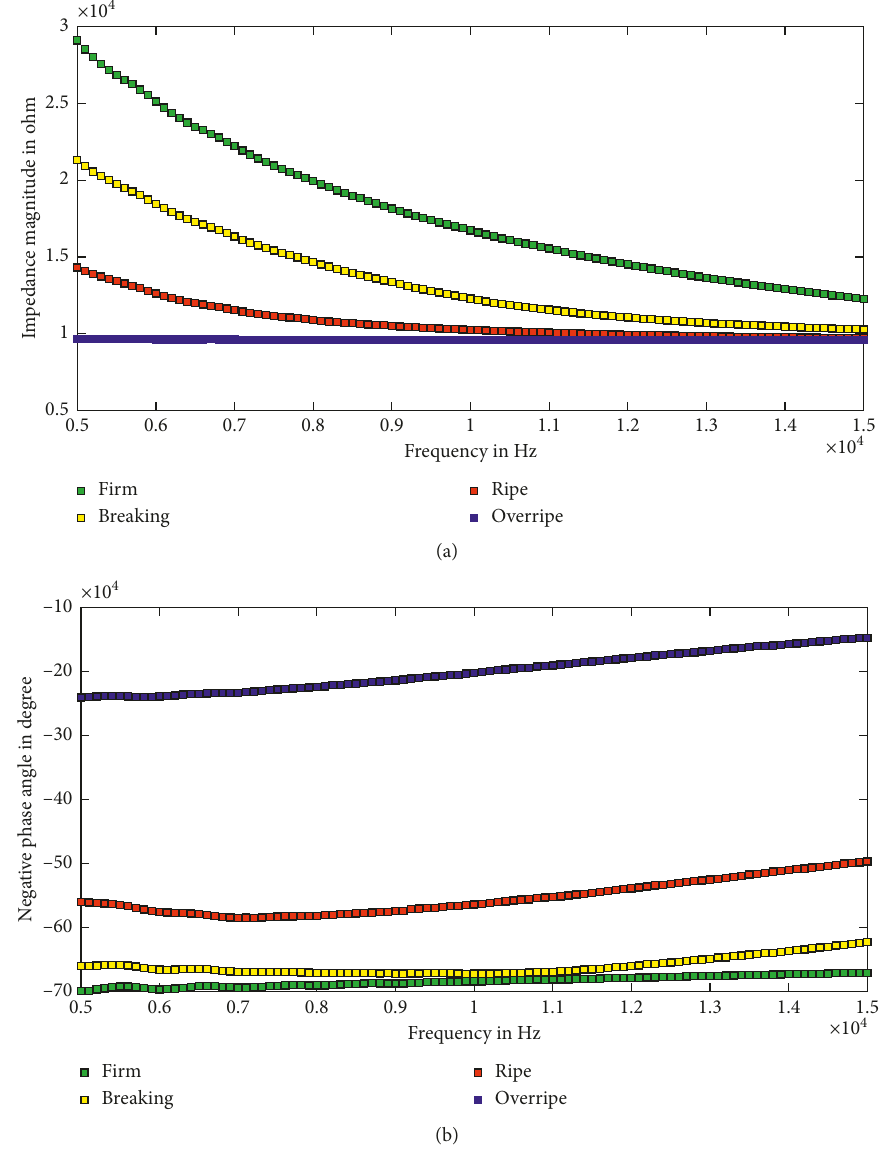
Figure 3: EIS response of avocado during ripening: (a) impedance magnitude vs. frequency and (b) negative phase angle vs.